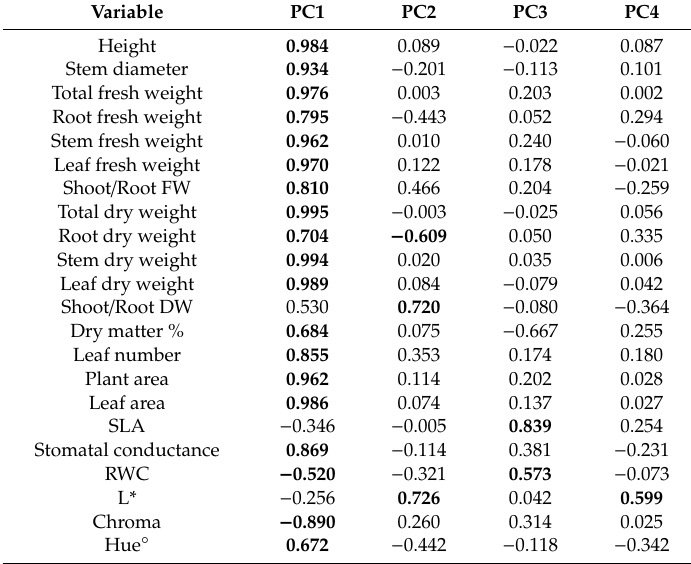
Table 5. Correlation of variables to the factors of the principal components analysis (PCA) based on factor